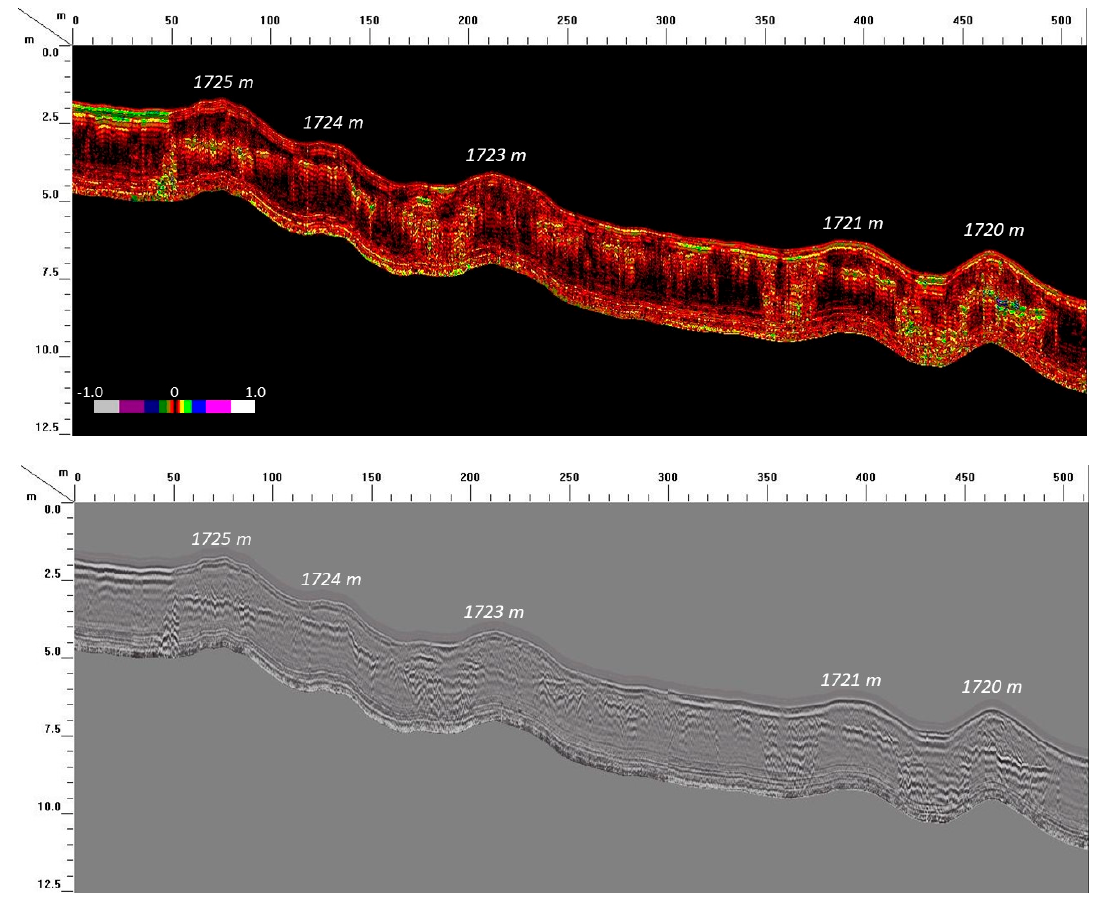
Figure 6. GPR profile for Transect A crossing the upper five shorelines, labeled with their elevations in meters above sea level. In the upper transect, data are presented with a color scale to highlight the normalized intensity of radar reflectors. The lower profile presents the same data in grayscale. In both profiles, landward is to the left and lakeward is to the right. A continuous, lakeward-dipping reflector is obvious beneath all of the shorelines. This reflector is interrupted by a high-angle offset ca. 140 m along the profile (beneath shoreline 1724 m). Enlargements and interpretations of the GPR data centered on each shoreline are presented in Figures 7–11. Vertical exaggeration 16×.